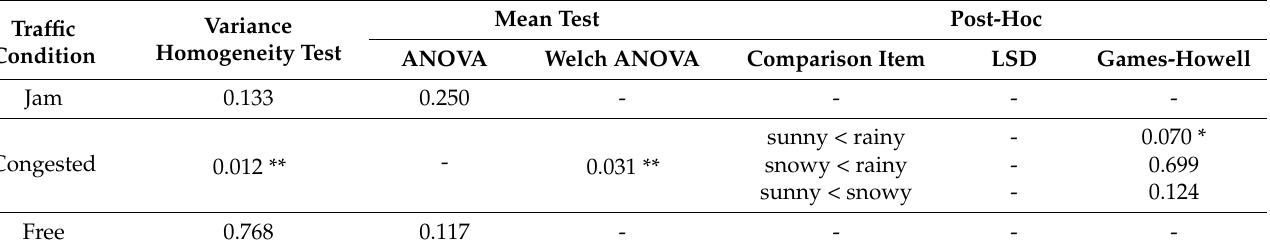
Table 14. Significance test of the influence of weather on the time taken to reduce to half speed.